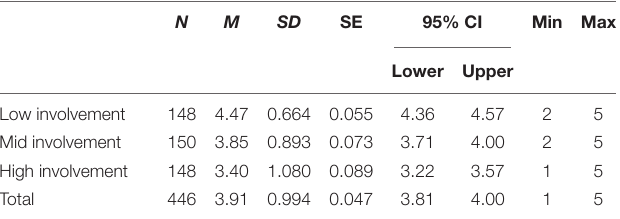
TABLE 2 | The impact of the AI involvement on patients’ WTA in the treatment scenario ( n = 446). N M SD SE 95% CI Min Max